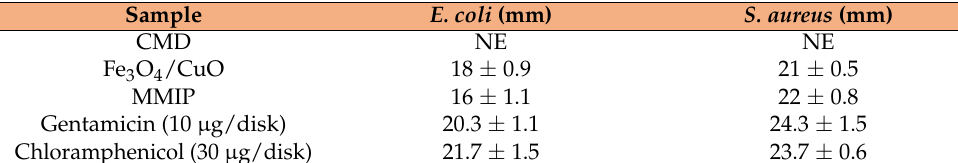
Table 2. Antibacterial activity data of Fe 3 O 4 /CuO, CMD, and MMIP against Escherichia coli ( E. coli ) and Staphylococcus aureus ( S. aureus ). The diameter of the inhibitory zone of bacteria was measured in millimeters (mm).